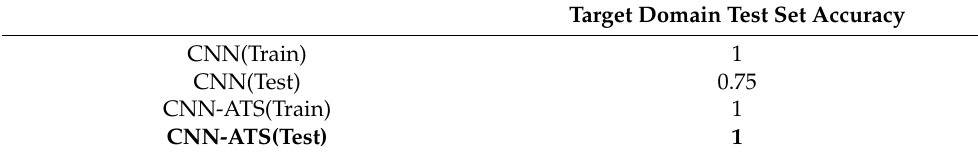
Table 5. Accuracy of the models.